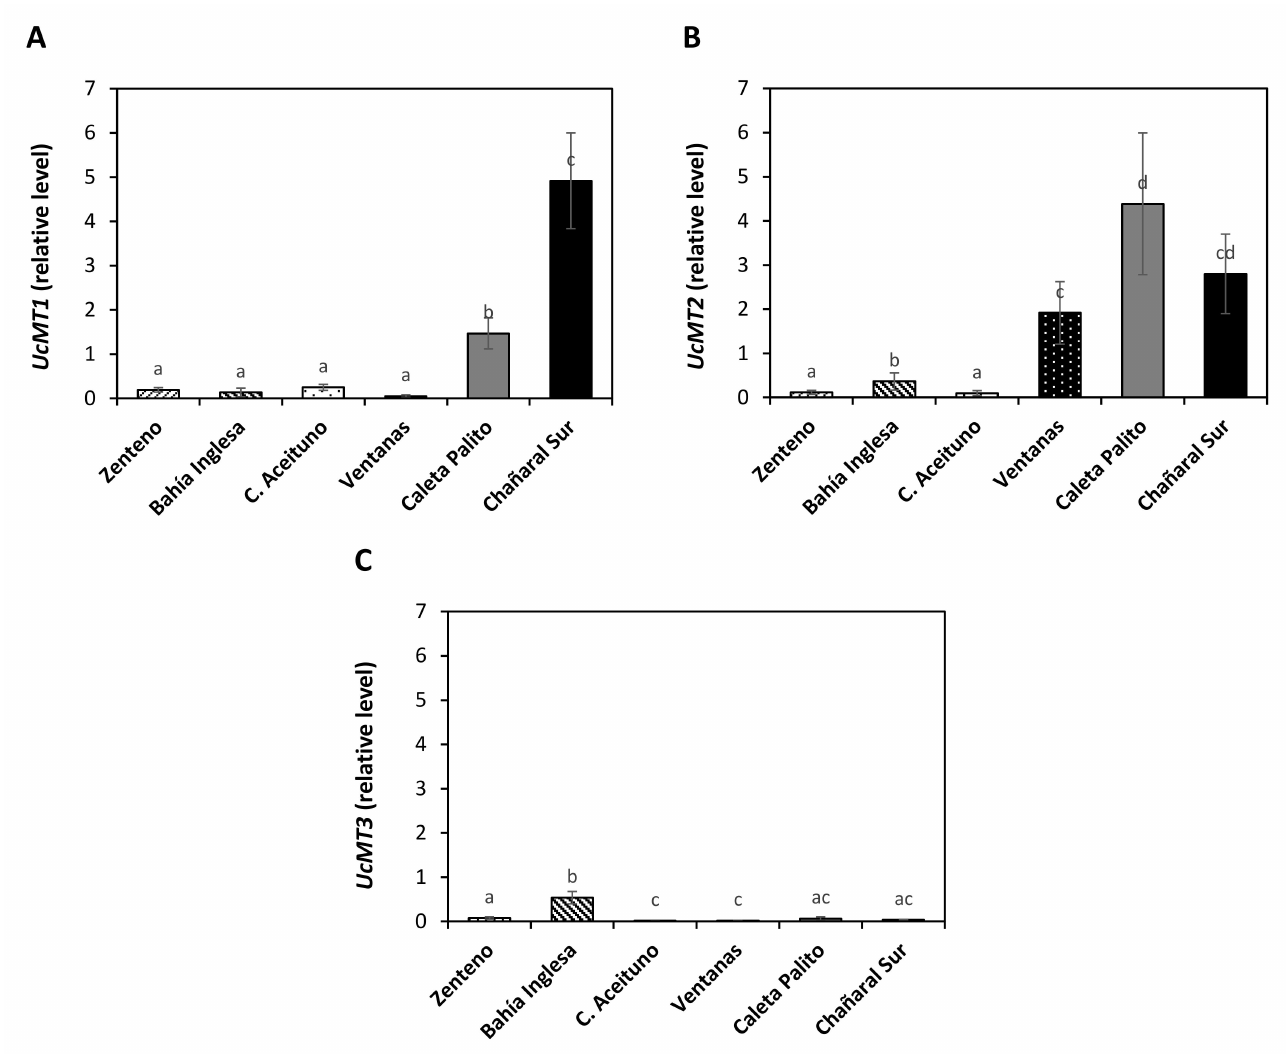
Figure 4. Relative level of transcripts encoding UcMT1 ( A ), UcMT2 ( B ) and UcMT3 ( C ) in algae of control sites and copper-polluted sites. The levels of transcripts are expressed as 2 - ∆∆ CT . Bars represent mean values of three independent replicates ± SD. Letters indicate significant differences ( p <